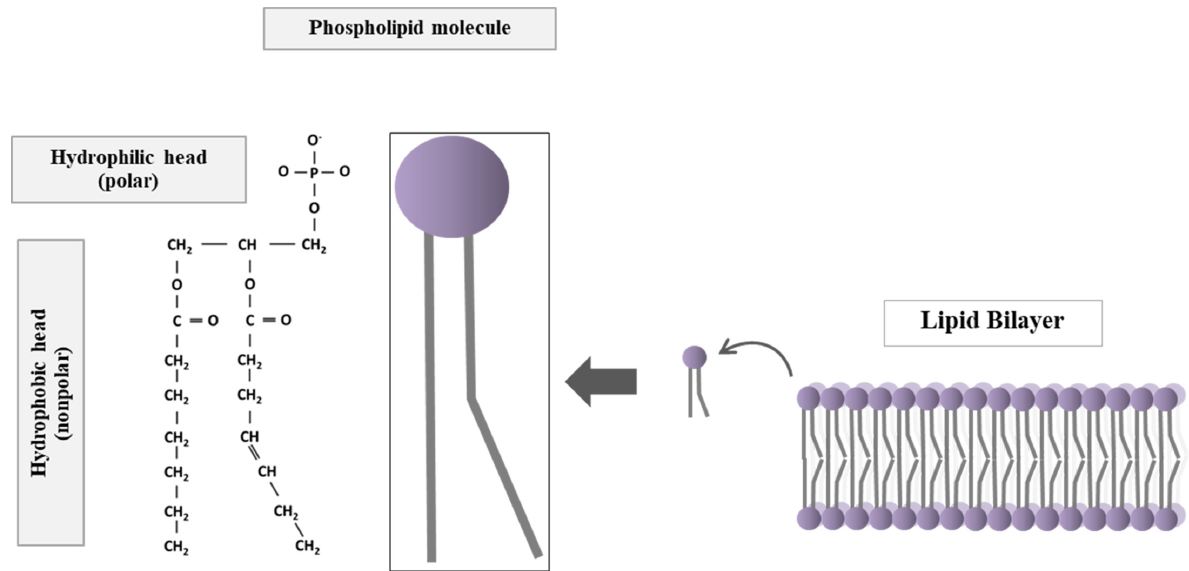
Figure 1. The phospholipid fatty acid (PLFA) method revealed different strategies engaged by microorganism’s population to adapt to the environmental changes such as soil types, climatic origins, and different